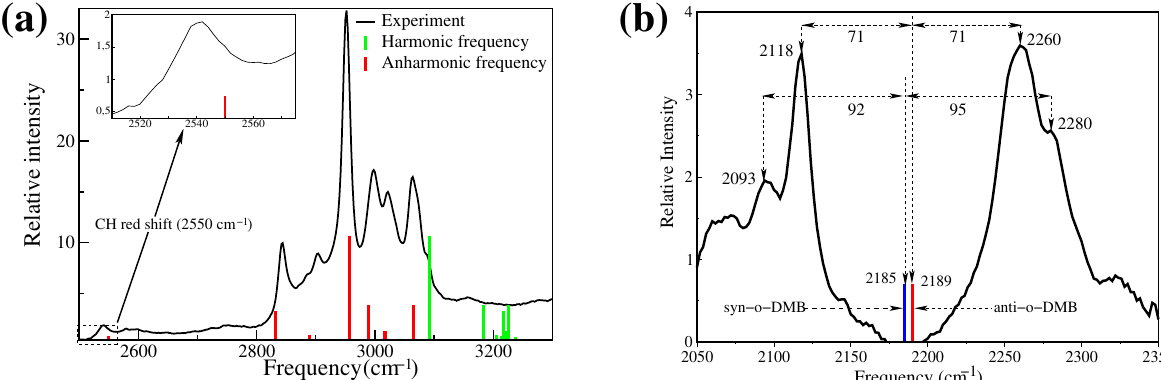
Figure 2. ( a ) The experimental 1D FTIR spectra (black line) of deuterated MB at the C-H absorption region. The calculated harmonic (green) and anharmonic (red) vibrational frequencies are plotted as a stick plot. The stick height represents the absorption strength of the peak. The absorption strength of harmonic frequencies is used to represent the peak strength of corresponding anharmonic frequencies. The red shift of the C-H vibration and corresponding calculated frequency are shown in the inset. ( b ) Frequency shift of C-D band due to Fermi resonance. The blue and red sticks are the calculated C-D frequencies of anti- and syn-o-DMB, respectively.